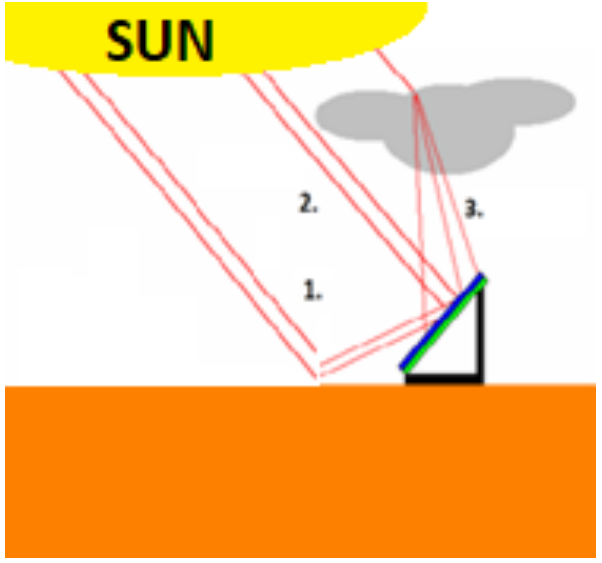
Figure 17. Main radiation types that may be incident on a photovoltaic solar